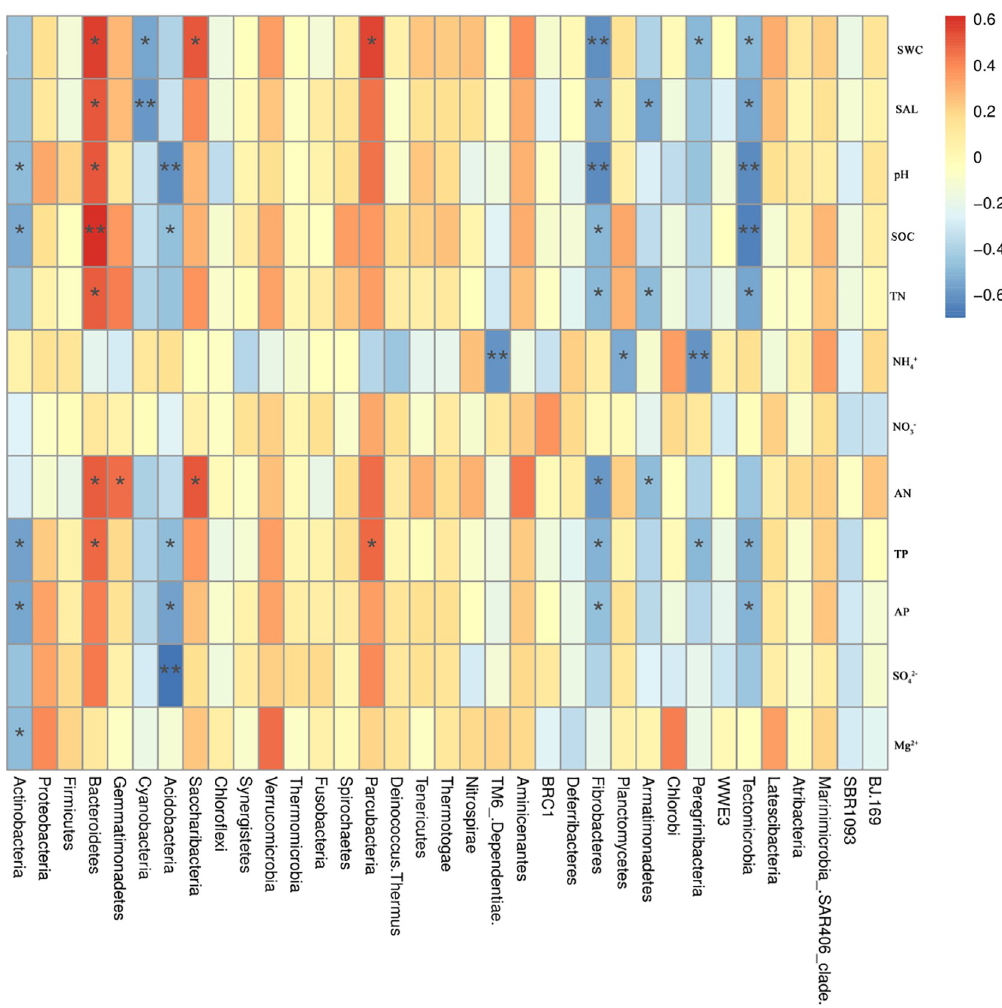
Fig 4. Correlation analysis between bacterial community composition and environmental